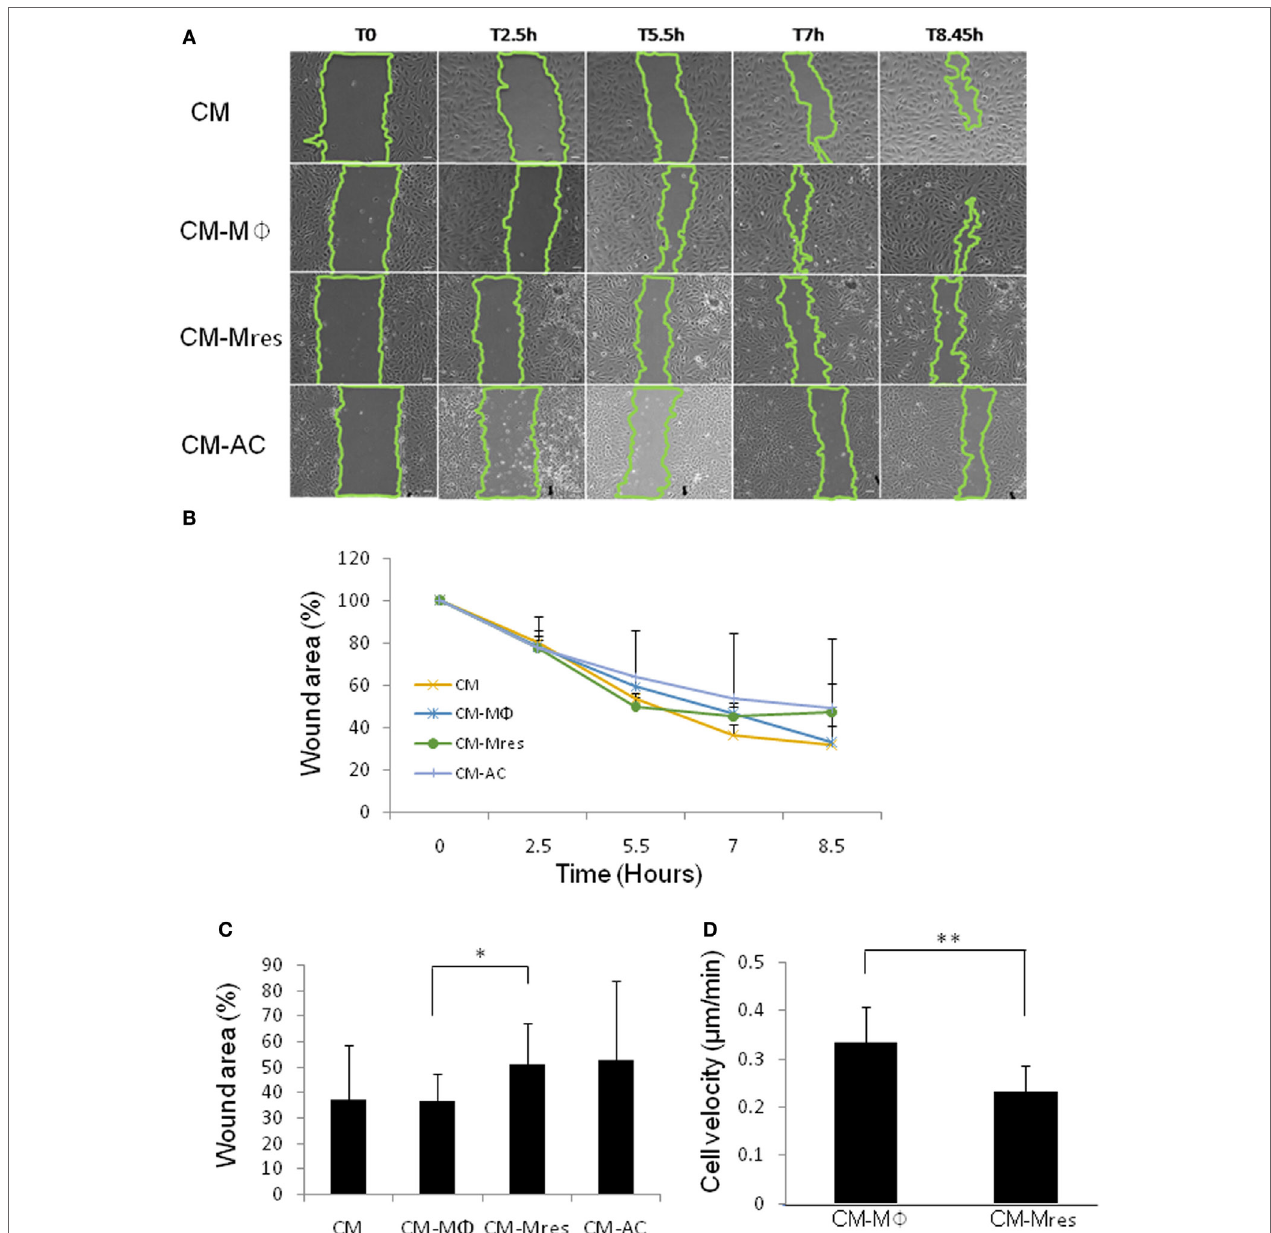
FigUre 2 | Motility of human umbilical vein endothelial cell (HUVEC) is attenuated upon treatment with CM-Mres. (a,B) Representative results ( n = 4) of wound migration assay of HUVEC treated with the indicated conditioned media. (a) Images taken at indicated time points demonstrate quicker wound closure upon treatment with either condition medium (CM) or CM-M ϕ compared with treatment with CM-Mres or CM-AC. (B) Quantification of the wound closure (motility of the cells) over time. Points; mean, bars; STD, n = 4. (c) Quantification of the wound closure at 8.5 h post wounding. Columns; mean, bars; STD, n = 6, one-way repeated measures ANOVA analysis with repeated contrasts, * p ≤ 0.05. (D) Motility of HUVEC cultured on gelatin for a period of 2 h upon treatment with either CM-M ϕ or CM-Mres was monitored by time-lapse microscopy. An average velocity of 10 different cells for each treatment was determined. Columns; mean, bars; STD, n = 10 cells for each treatment, t -test, * p ≤ 0.05, ** p ≤